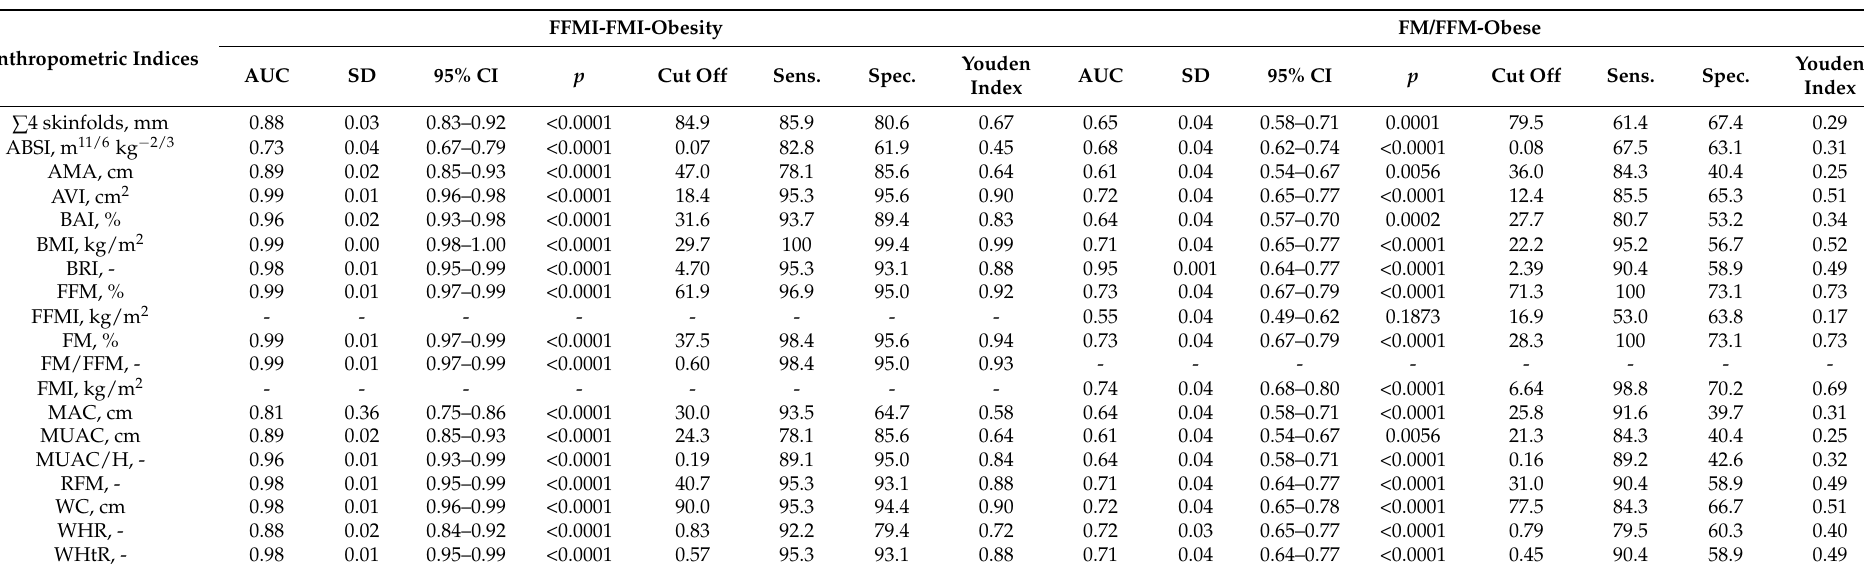
Table 4. The area under ROC curve (AUC), optimal cut-off values, sensitivity (Sens.), specificities (Spec.) and Youden index of anthropometric indices in